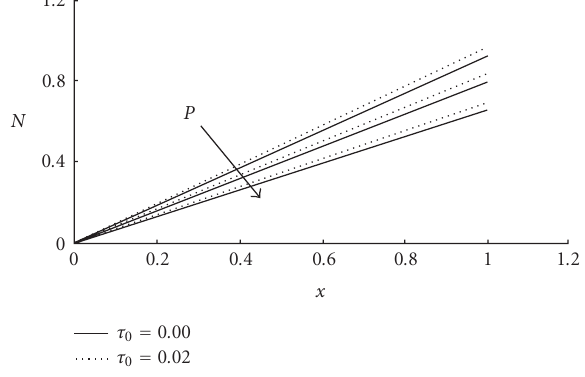
Figure 5.5. Local Nusselt number, where P = 0 . 9,0 . 7,0 . 5, versus x